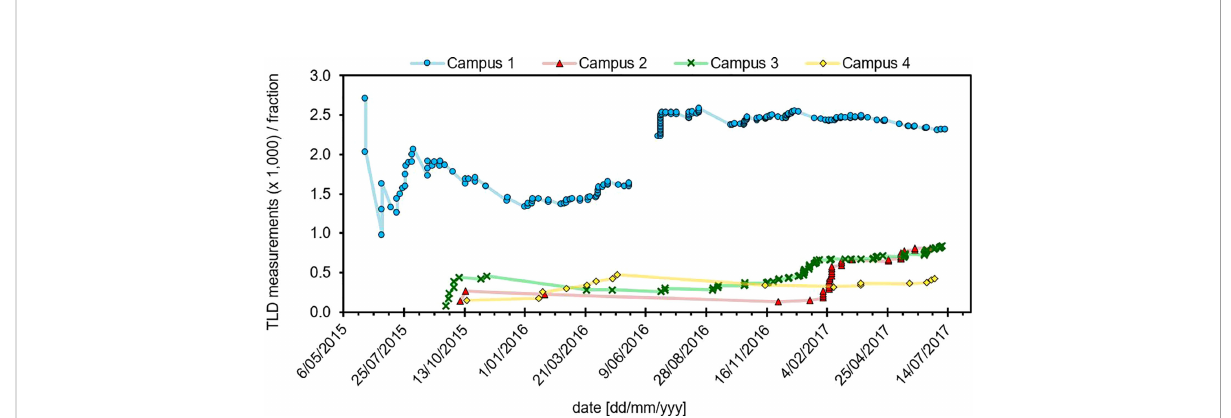
FIGURE 2 Role of the TLD service across each campus over a two-year time frame. Campus 1 and 2 were relocated to new facilities, which opened in July 2016 and January 2017,